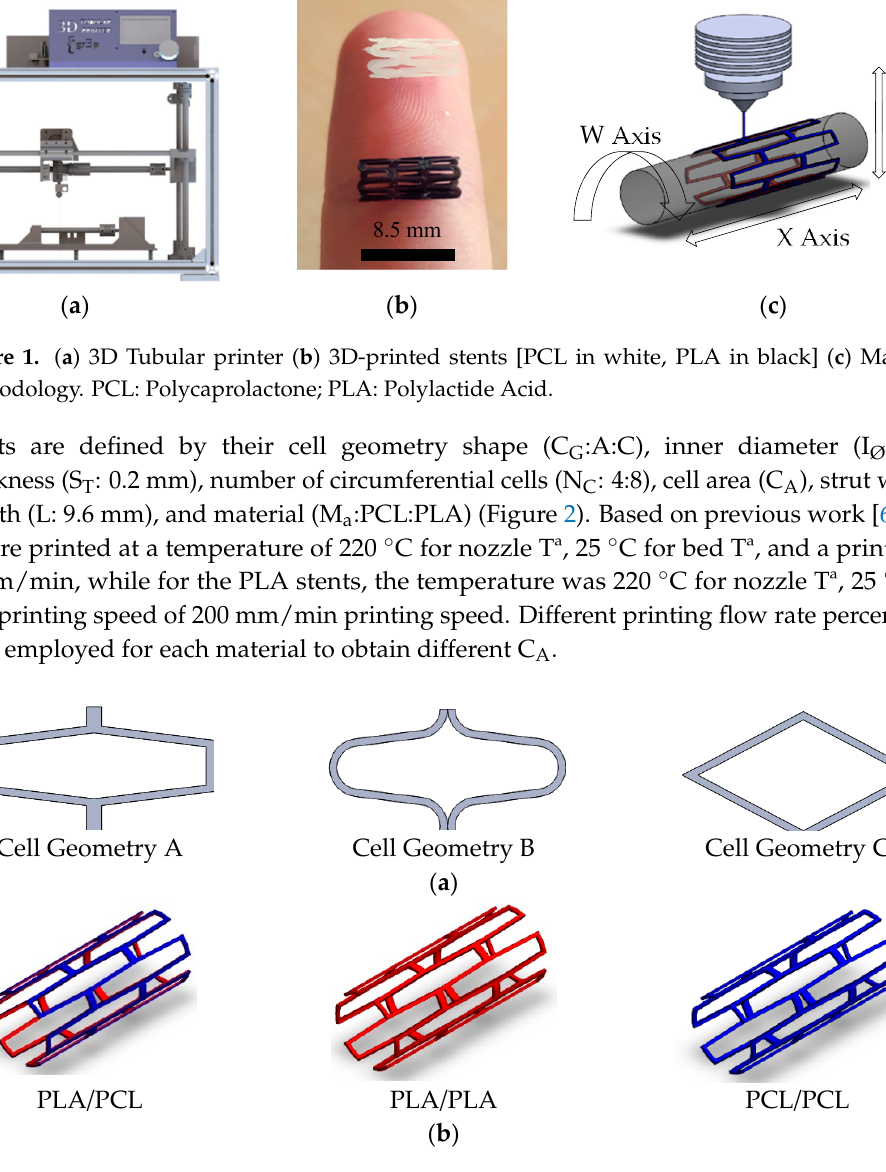
Figure 2. Stent configurations: ( a ) Stent cell geometries employed; ( b ) Stent material/layers used.